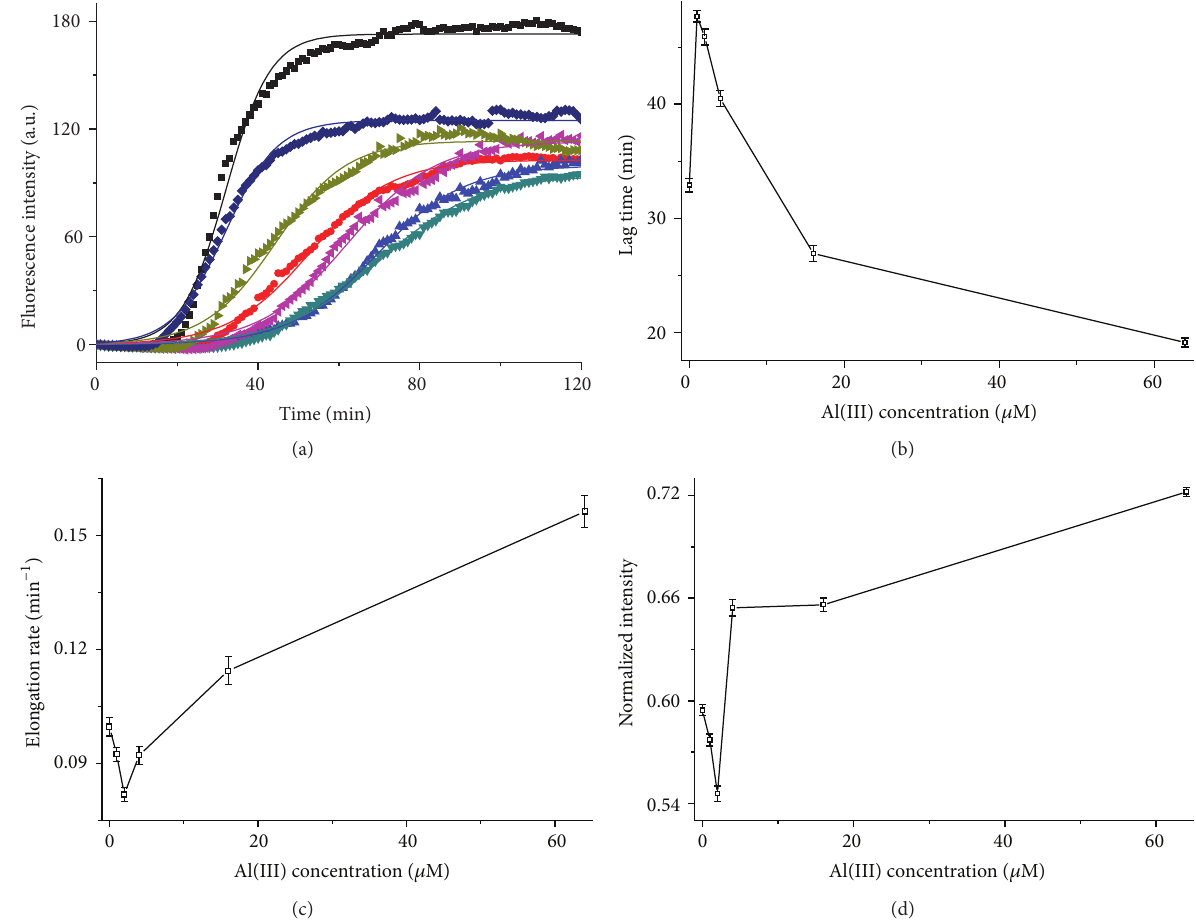
Figure 9: The influence of Al(III) on the EGCG-interfered hIAPP fibrillation. (a) Kinetics of 16 𝜇 M hIAPP fibrillation without ( ◼ ) or with 2 𝜇 M EGCG interfered by addition of 0 ( e ), 1 ( 󳵳 ), 2 ( 󳶃 ), 4 ( 󳶣 ), 16 ( 󳶳 ), and 64 ( X ) 𝜇 M Al(III) monitored by ThT fluorescence. The values represent mean ( 𝑛 = 3 ). Solid lines represent the curves fitted using (1). (b) Lag time, (c) elongation rate, and (d) the normalized maximum ThT fluorescence of hIAPP aggregation with 2 𝜇 M EGCG on the Al(III) concentration. The intensity values were normalized to hIAPP alone